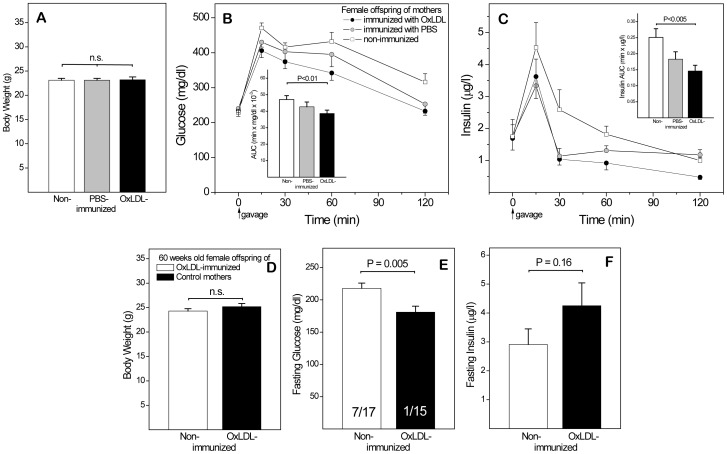
Protective effects of maternal OxLDL immunization in female offspring.(A–C) Female offspring of mothers immunized with OxLDL or PBS and non-immunized controls fed 60% sucrose diet for 24 weeks (n = 27). Body weights, glucose responses and insulin responses during an OGTT at this time are shown, together with respective AUCs (insets). (D–F) A second group of female offspring was reverted to regular chow for 19 weeks after insulin resistance had been induced by 36 weeks on the sucrose diet. Body weights, plasma glucose and insulin levels (after 6 hr. fasting) were determined at 60 weeks of age. Numbers of mice with glucose levels ≥230 mg/dl and total number in each group are indicated in the bars of panel E.